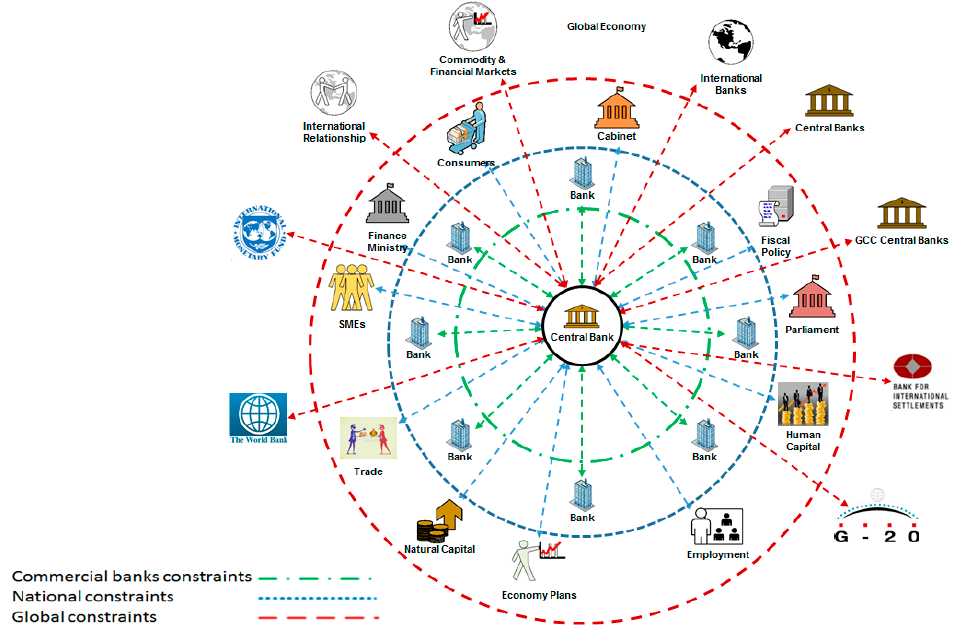
Figure A1. Central banks’ regulatory policy multidimensional constraints.